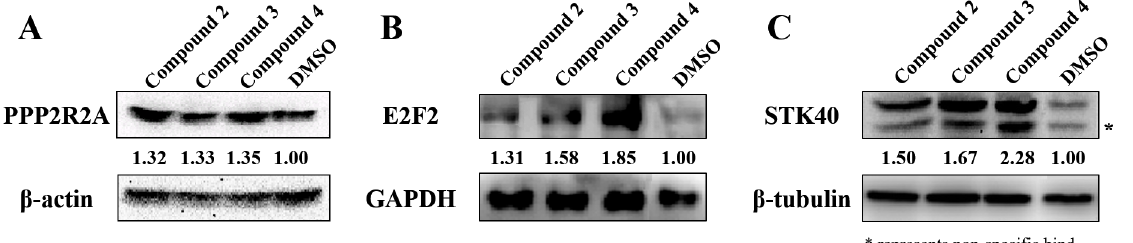
Fig 5. Protein expression of miR-31 targets following compound treatment. A549 cells were treated with compounds 2, 3, and 4 and lysed with RIPA buffer. Total protein concentration was calculatedusing a BCA assay kit, and 20 μ g of total protein was used for western blot analysesof PPP2R2A (A), E2F2 (B), and STK40 (C). The intensity of each blot was normalized against that of β -tubulin.Bands were detected using the ChemiDoc ™ XRS+ System. ( * represents non-specific band).